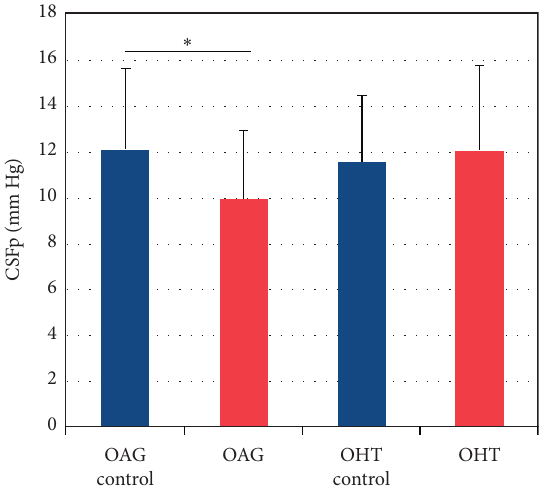
Figure 2: CSFp trends from 1985 to 2019. There is a significant difference in CSFp between OAG patients and controls. There is not a significant difference in the CSFp of OHT patients and controls. CSFp, cerebrospinal fluid pressure; OAG, open-angle glaucoma; OHT, ocular hypertension. ∗ p < 0 .